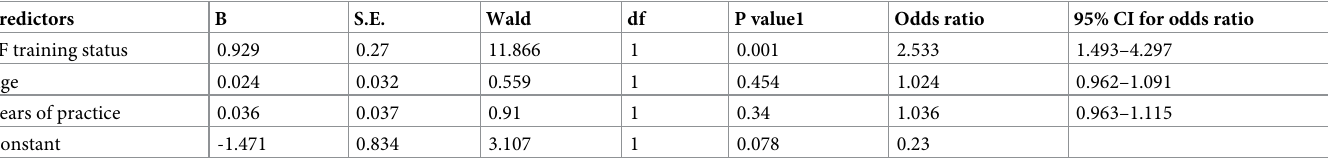
Table 7. Predictors of knowledge overestimation of Lassa fever and its prevention and control measures among healthcare workers during an outbreak in Katsina, Nigeria (N = 276).